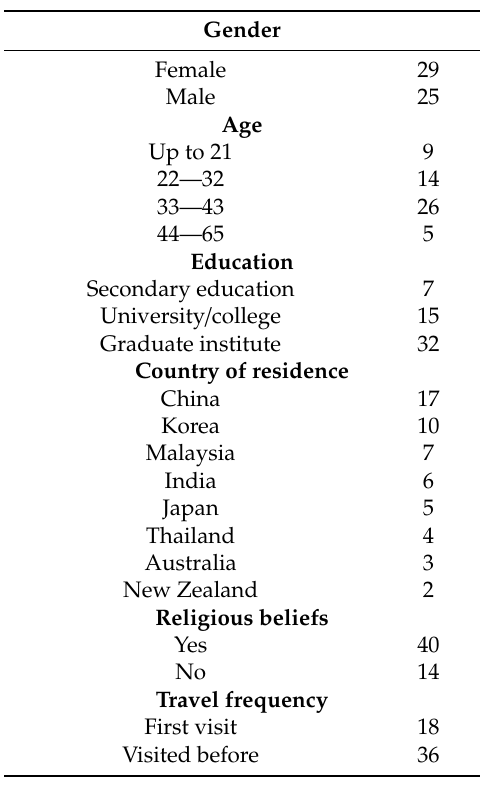
Table 1. Selected respondent characteristics ( N = 54).